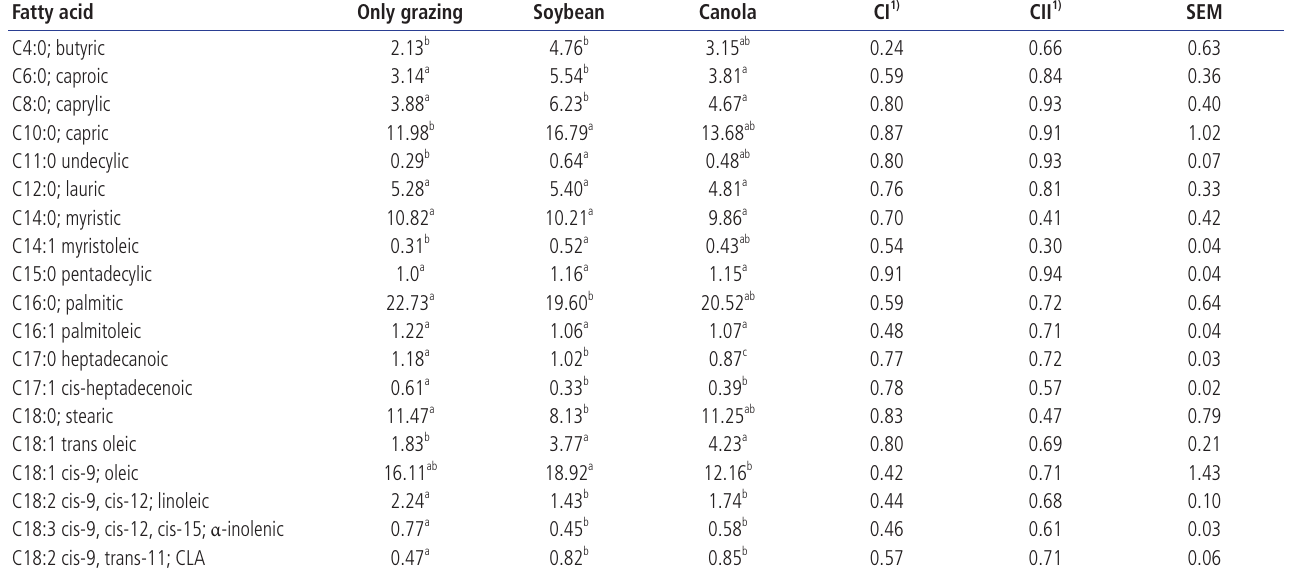
Table 2. Effects of soybean and canola oil on fatty acid composition (g/100 g) of milk fat in goats Fatty acid Only grazing Soybean Canola CI 1) CII 1)